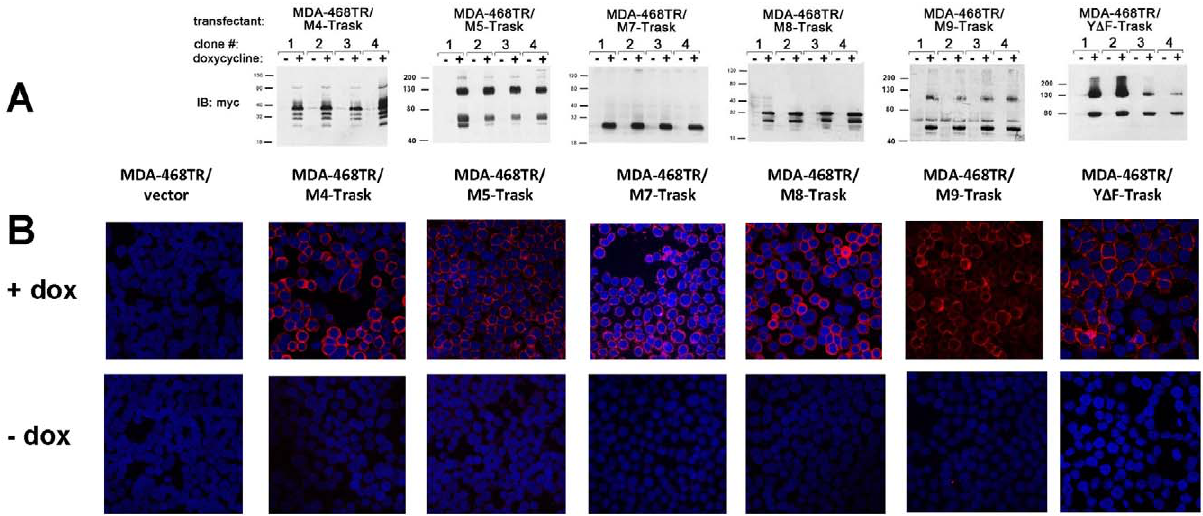
Figure 2. Inducible expression of Trask mutants in MDA-468 cells. A ) MDA-468TR cells were engineered to inducibly overexpress the M4, M5, M7, M8, and M9 and Y D F Trask mutants in response to doxycycline treatment. For each construct four clones were studied to account for clonal variability. The dox-inducible expression of the M4, M5, M7, M8, and M9 and Y D F Trask mutants are shown by anti-myc immunoblots. The myc immunoblots for the wt-Trask over-expressing cells were previously published [7]. These induction blots are representative of two experiments done with the entire clone set, and with 4 experiments done with selected Trask-M4 and Trask-Y D F clones. B ) The membrane localization of each of the induced constructs was verified following doxycycline induction by anti-myc staining of fixed cells and immunofluorescence microscopy.